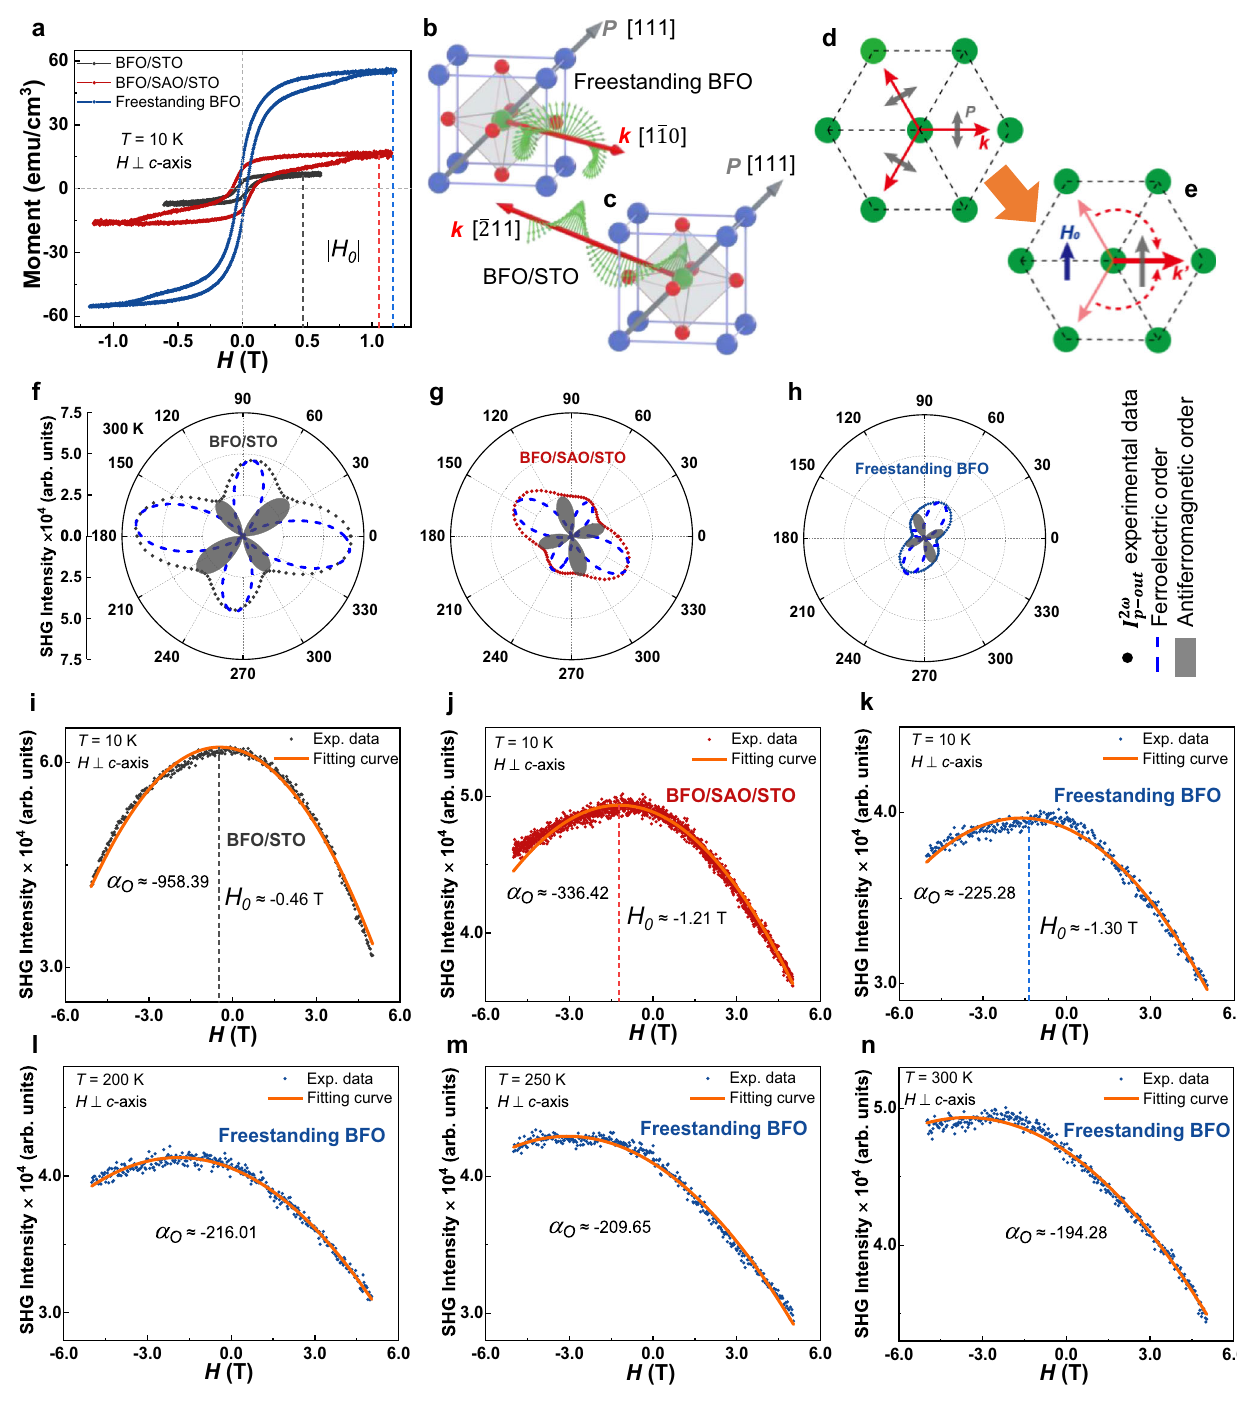
Fig. 3 | SHG with applied magnetic fi eld and M-H measurements. a M-H dia- grams of BFO/STO, BFO/SAO/STO, and freestanding BFO fi lms transferred onto STO (001) substrates. b , c Schematic diagrams of the non-collinear G-type cycloid antiferromagnetic order in the freestanding BFO fi lms with low strain and that in BFO/STO fi lms with high strain, respectively. d Schematic diagram of the rela- tionshipbetweenpolarization P andcycloidalvectors k withoutthemagnetic fi eld. e Schematic diagram of the relationship between polarization P and cycloidal